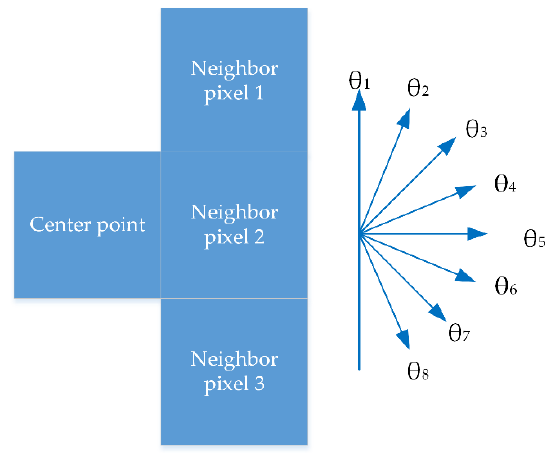
Figure 9. Center point at the edge of the object.